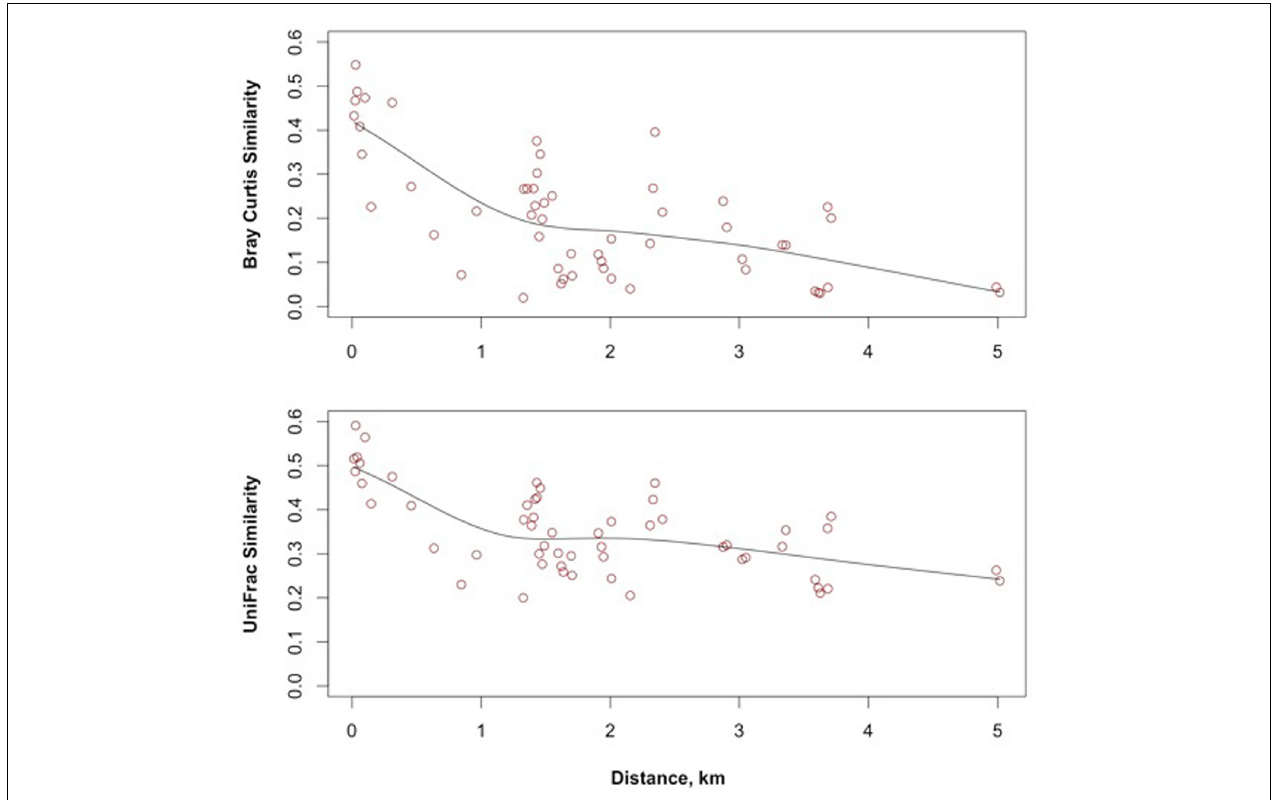
FIGURE 5 | Bray–Curtis and UniFrac distance decay relationships of groundwater bacteria across the study